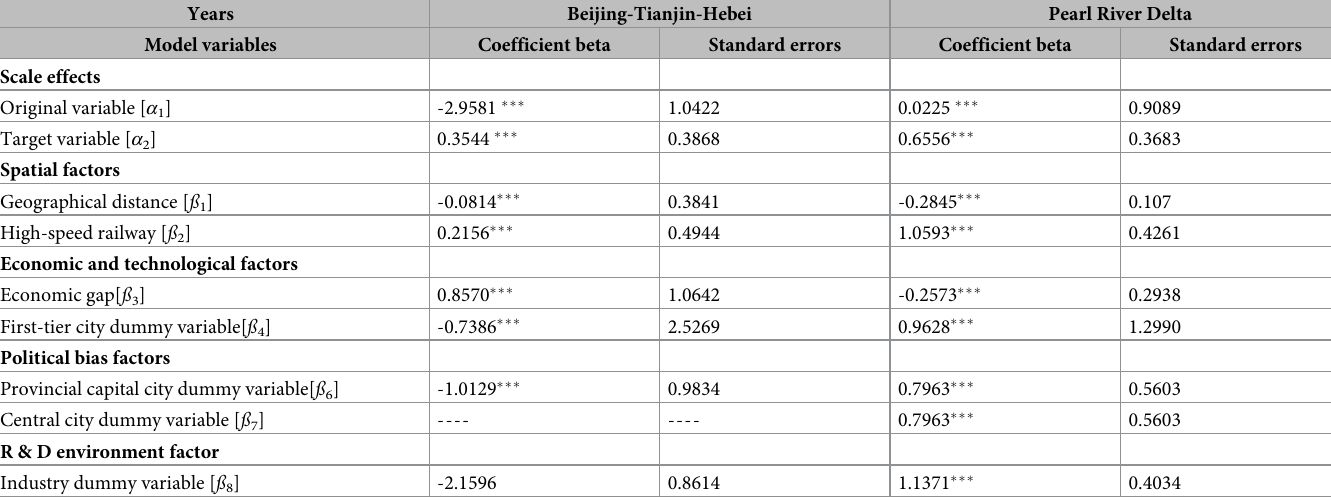
Table 15. Estimation results of the negative binomial spatial interaction model, based on common patents among cities in Beijing-Tianjin-Hebei and Pearl River Delta urban agglomerations